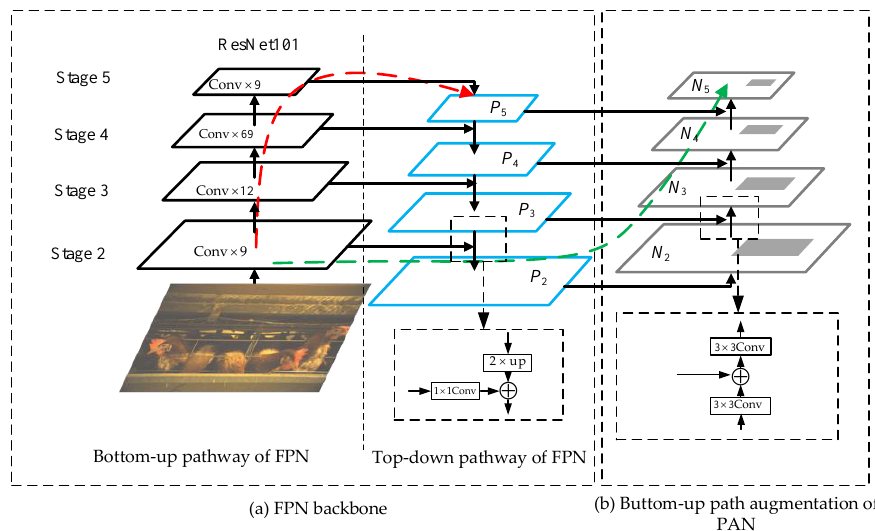
Figure 4. Structure of the improved feature extraction network. Conv: convolution, up: upsampling, ⊕ : add.